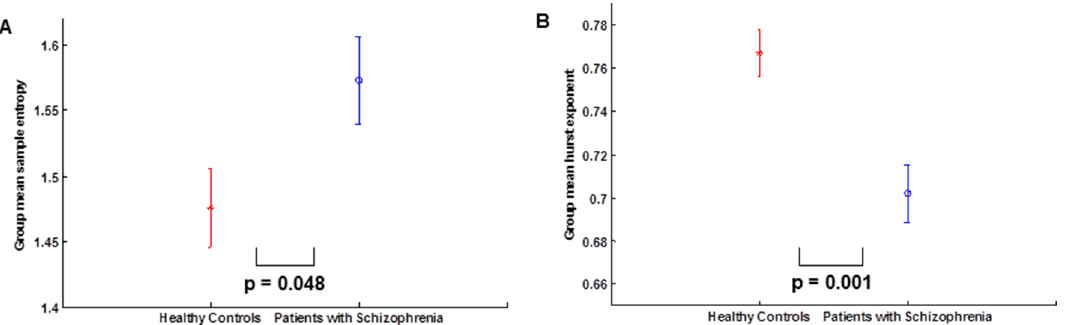
Figure 3. Group mean complexity differences after correcting for age and sex differences together in the GLM. (A) Group mean Sample entropy. (B) Group mean Hurst